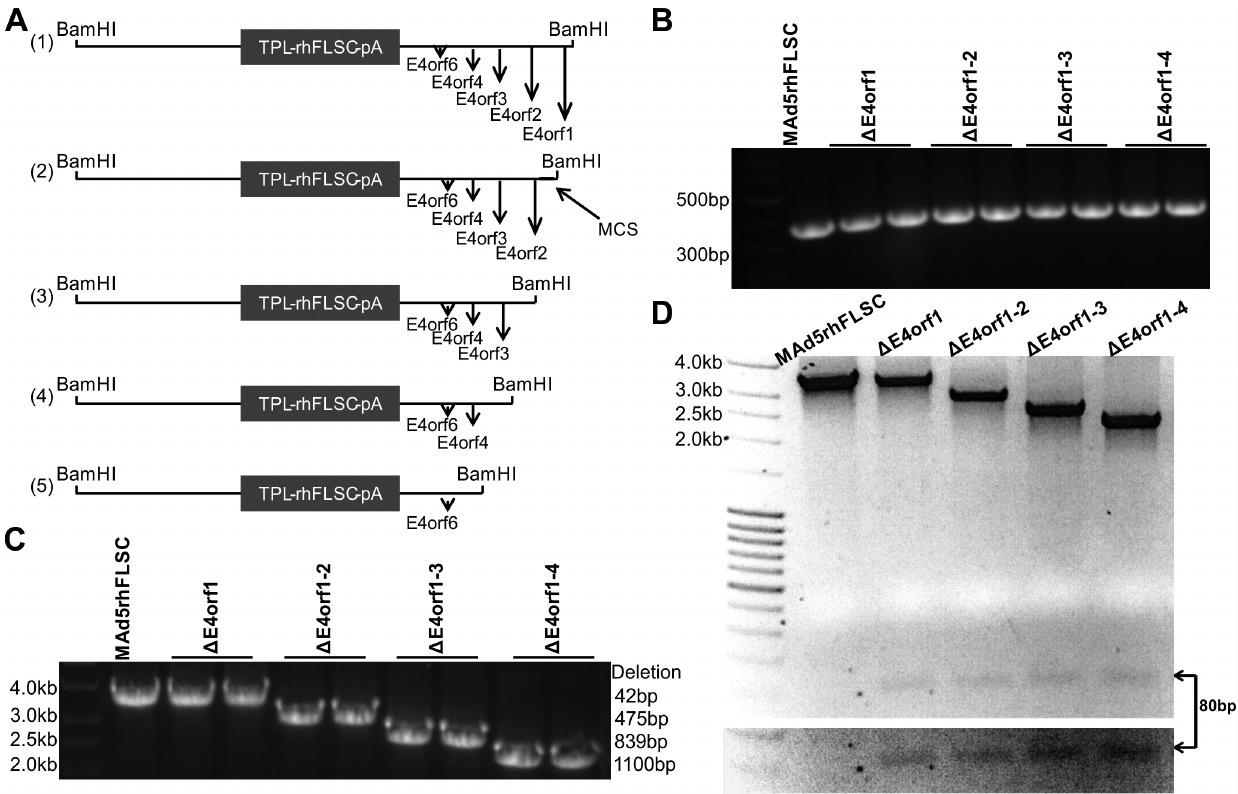
Figure 1. Construction and verification of Ad5 hr-rhFLSC variants with deletions in E4orf1 , 1–2 , 1–3 , and 1–4 . (A) Schematic diagram of gel purified BamHI digested pBRAd5 D E3 (TPL-rhFLSC-pA) shuttle plasmids. ( B ) Using the primers listed in Table S1 PCR products were obtained from the parental Mad5rhFLSC and deleted viruses and run on a 0.8% agarose gel. The fragment from the D E4orf1–4 virus containing an 1100 bp deletion, the D E4orf1–3 virus containing an 839 bp deletion, the D E4orf1–2 virus containing a 475 bp deletion and the D E4orf1 virus containing a 42 bp deletion were run with Mad5rhFLSC as a control. ( C ) NsiI digestion liberated an 80 bp fragment seen at the bottom of the gel in each of the E4- deleted viruses but not in the parental virus MAd5rhFLSC. The bottom portion of the gel was overexposed to provide better visualization of the 80 bp fragment. ( D ) The concentrations of the purified viruses were obtained by optical density (1 OD unit at 260=1.0 6 10 10 PFU/mL) and plaque assays on 293 cells. The particle to plaque ratios are shown.